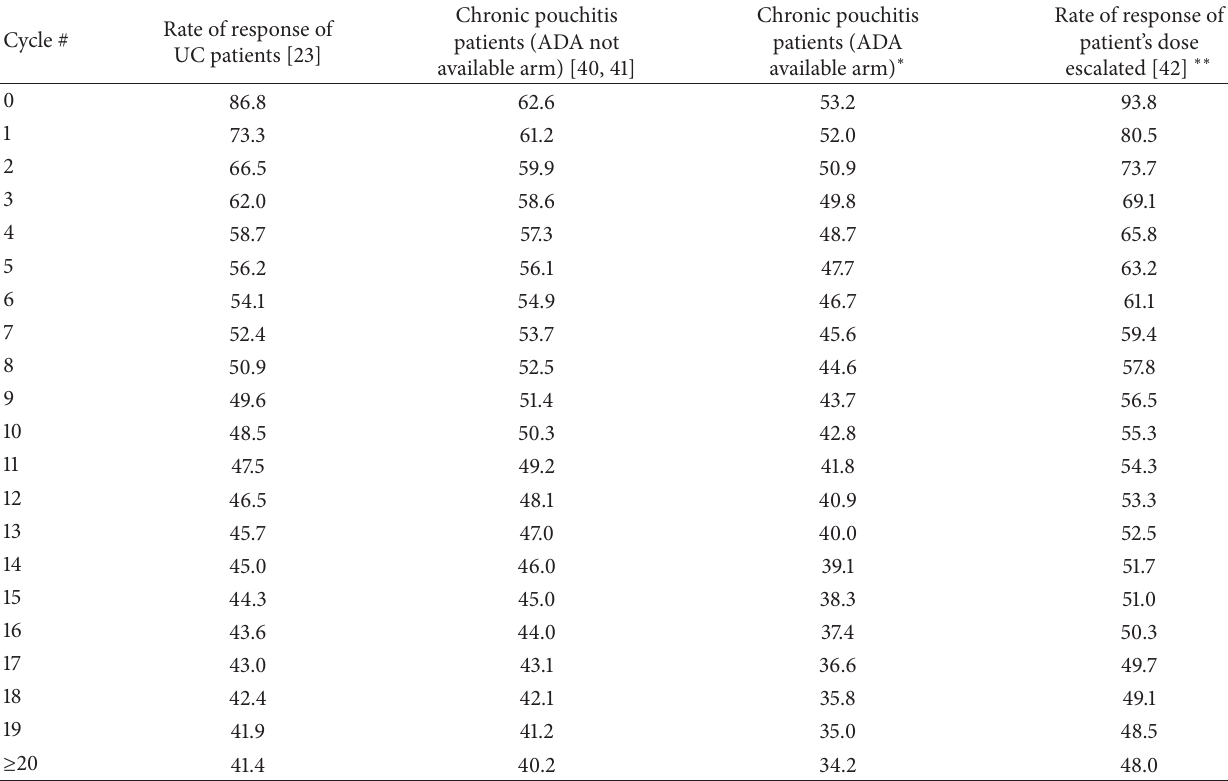
Table 5: Maintenance probabilities of patients on adalimumab over